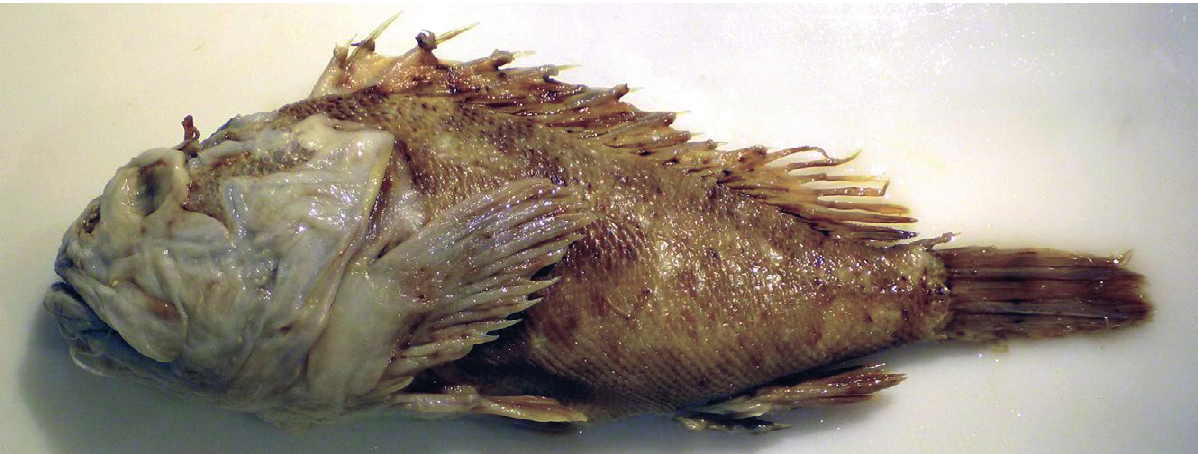
Fig. 3. – Scorpaena porcus Linnaeus, 1758, HUJ 12258, 153 mm SL, Jaffa, Israel, Mediterranean Sea, 23 Apr. 1987. Lateral view; photograph of the fresh colouration taken a few hours after collection (Photograph: D. Darom).